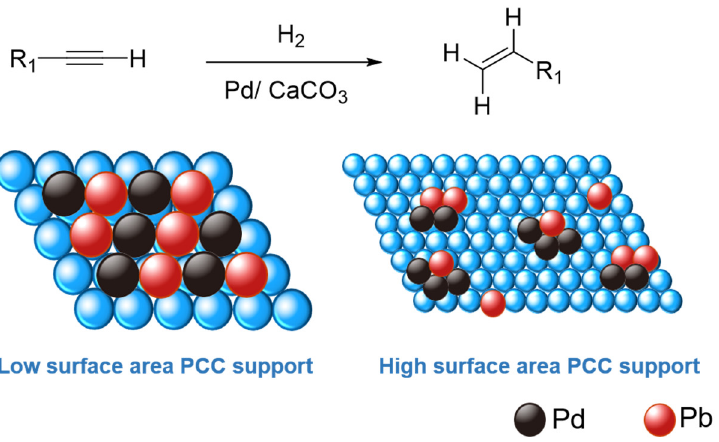
Figure 1. Simplistic illustration of “active-site isolation” concept over low- and high-surface-area precipitated CaCO 3 (PCC) supports.